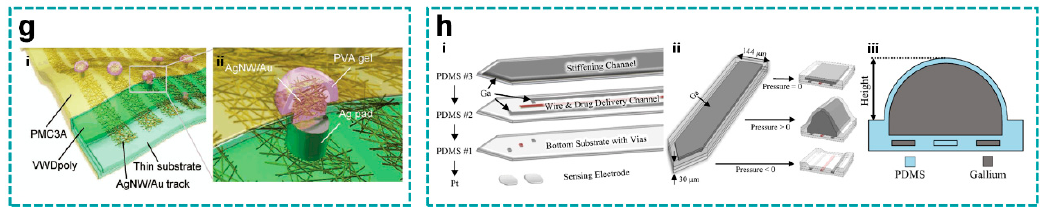
Figure 8. Special interconnects. ( a ) a transparent micro-ECoG array based on graphene (reprinted with permission from [80]); ( b ) a stretchable transparent electrode array from carbon nanotube (CNT) web-like Table [113]); ( c ) a high-performance indium tin oxide (ITO)/metal grid hybrid flexible transparent microelectrode (reprinted with permission from [114]); ( d ) a microfabrication technique for patterning flexible, cloth-like, polymer-derived carbon fiber mats embedded in polyimide (PI) by selective reactive ion etching (reprinted with permission from [115].); ( e ) polypyrrole (PPy) electrode materials modified by nanowires through a simple electro-polymerization process (reprinted with permission from [116].); ( f ) a novel 3D printable conducting polymer ink (reprinted with permission from [77].); ( g ) stretchable transparent Ag/Au nanowires encapsulated in transparent polymer and connected to hydrogel-coated microelectrodes through silver pads (reprinted with permission from [117].); ( h ) a neural probe using gallium (Ga) in the probe construction as interconnects (reprinted with permission from [81].).